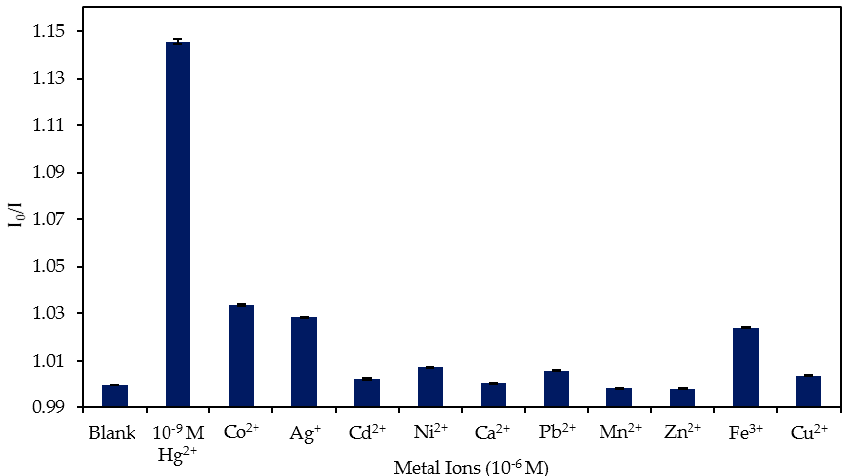
Figure 10. Comparison of the I 0 /I ratio of the sensor in the absence of metal ions (blank), in the presence of 10 − 9 M Hg 2+ and in the presence of 10 − 6 M of Co 2+ , Ag + , Cd 2+ , Ni 2+ , Ca 2+ , Pb 2+ , Mn 2+ , Zn 2+ , Fe 3+ , and Cu 2+